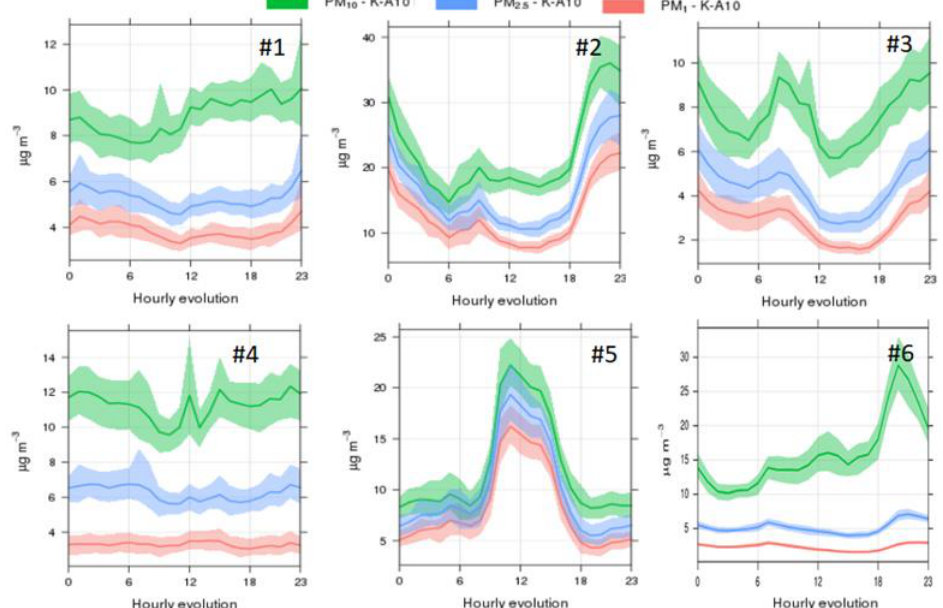
Figure 3. Mean daily evolution of PM 10 , PM 2.5 and PM 1 for the months July–September 2019, for the 6 stadia in major cities in: #1: Europe, #2: Africa, #3: Oceania; #4: Asia; #5: America; #6: Africa (data